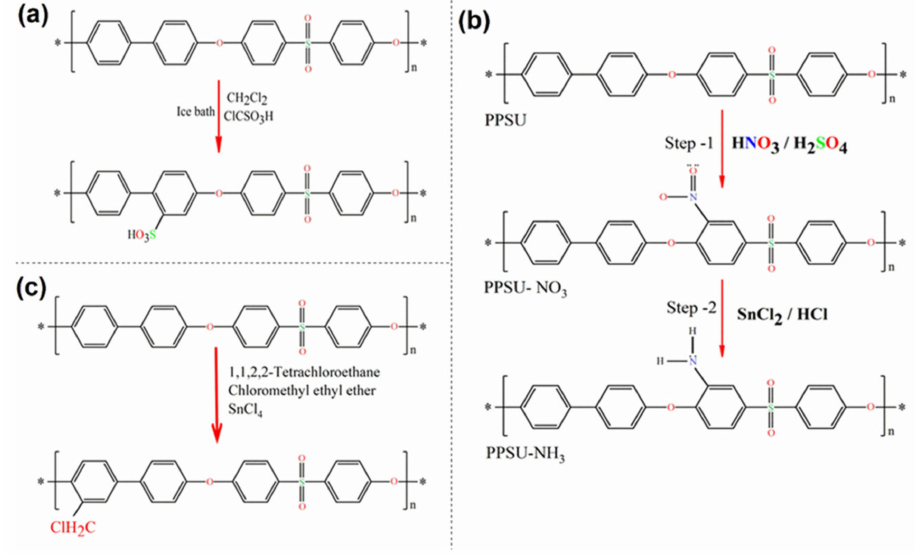
Figure 4. Synthesis of polyphenylsulfone. Reaction pathways: ( a ) sulfonation; ( b ) amination; ( c )